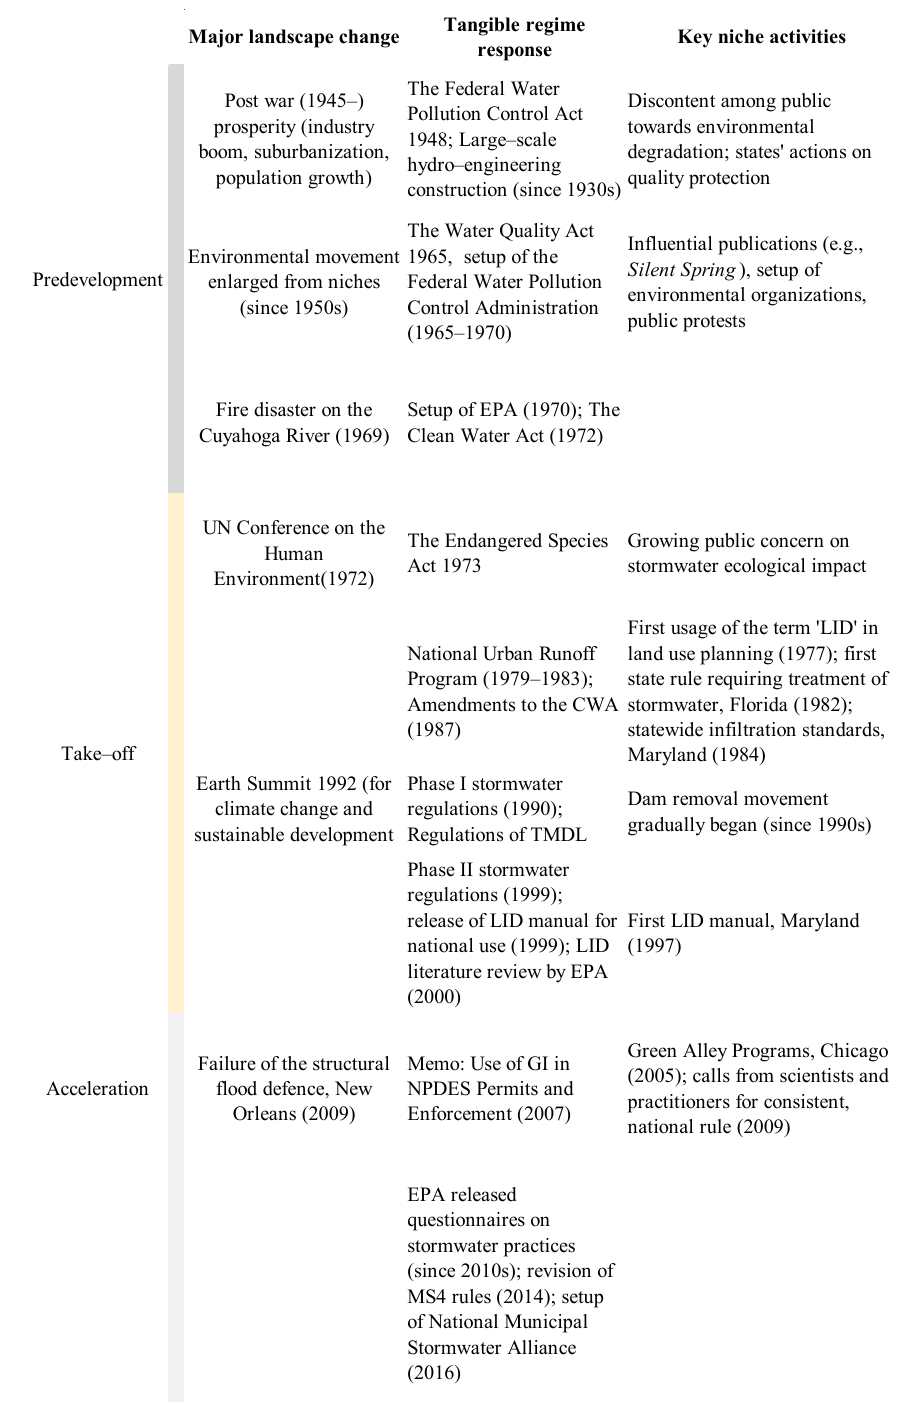
Figure 1. The transition trajectory of the U.S. stormwater management.